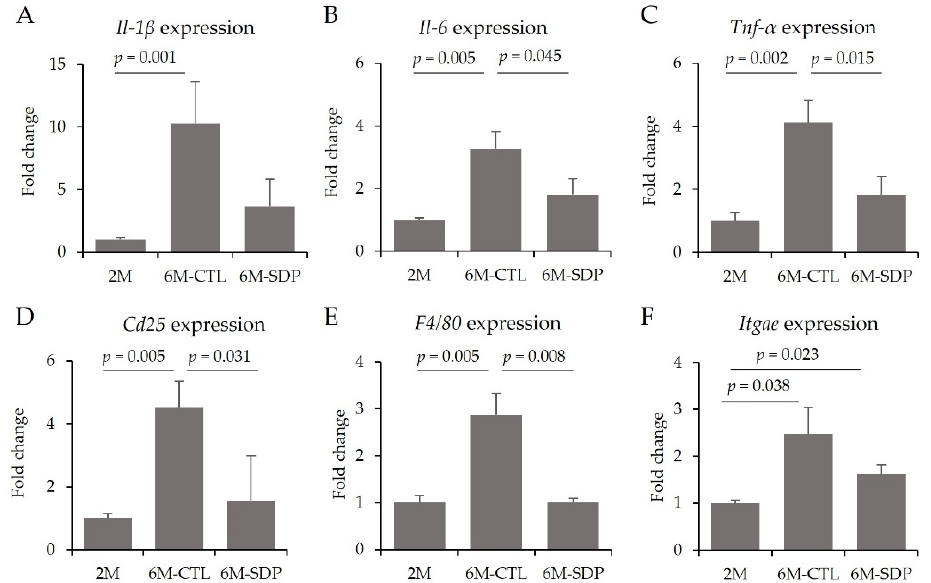
Figure 12. Inflammation in colon tissue. Gene expression of Il-1 β ( A ), Il-6 ( B ), Tnf- α ( C ), Cd25 ( D ), F4/80 ( E ), and Itgae ( F ). Results are expressed as mean ± SEM ( n = 9 − 11 mice/group). Statistics: ANOVA (Fisher multiple comparison test) and Kruskal–Wallis test. Cd25, cluster of differentiation 25; Itgae, integrin alpha e; Il, interleukin; Tnf- α , tumor necrosis factor